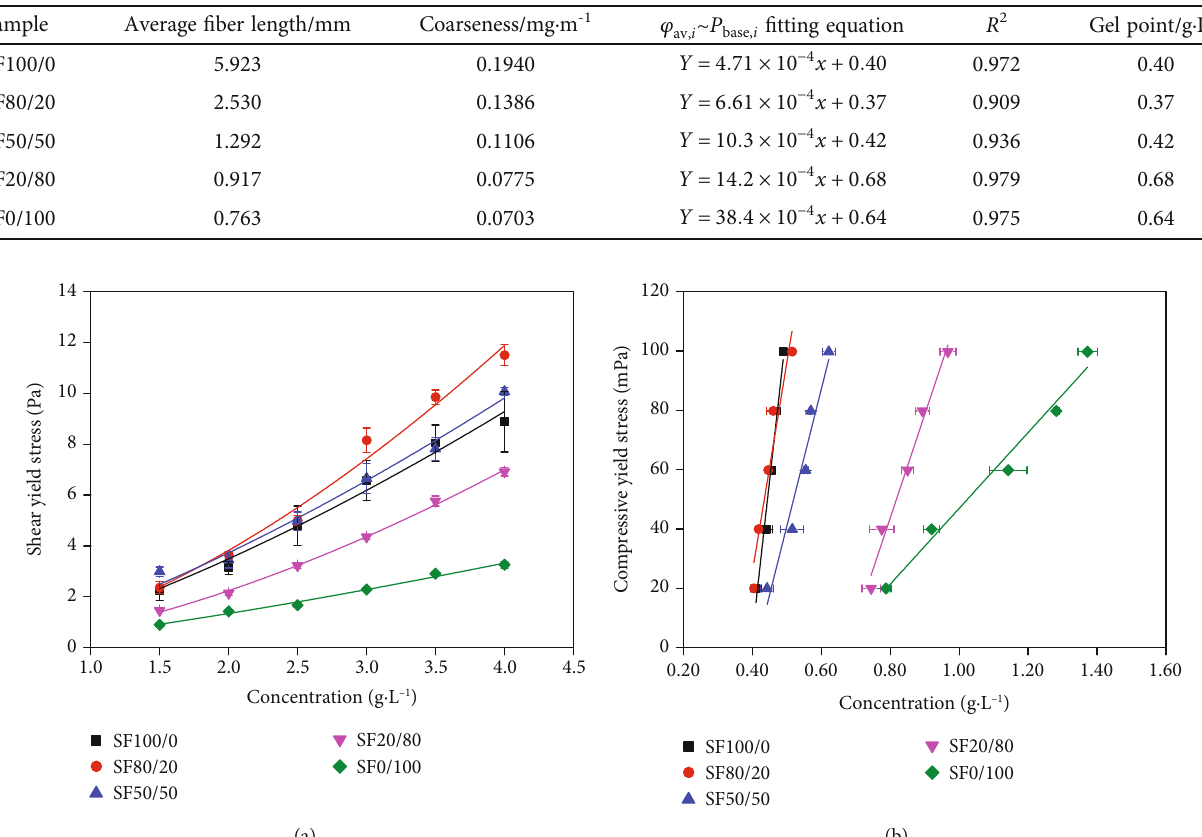
Figure 4: Yield stress values of aramid fi ber suspensions as a function of concentration under (a) shear and (b)